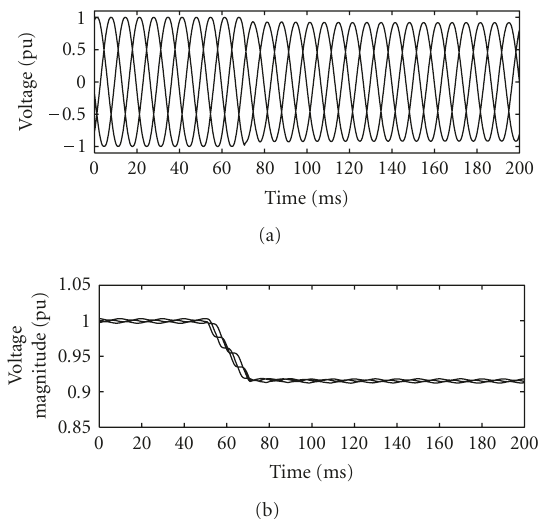
Figure 6: Voltage disturbance due to load switching: step change measurement: (a) voltage waveforms; (b) voltage magnitude (mea- surement in an 11kV network).